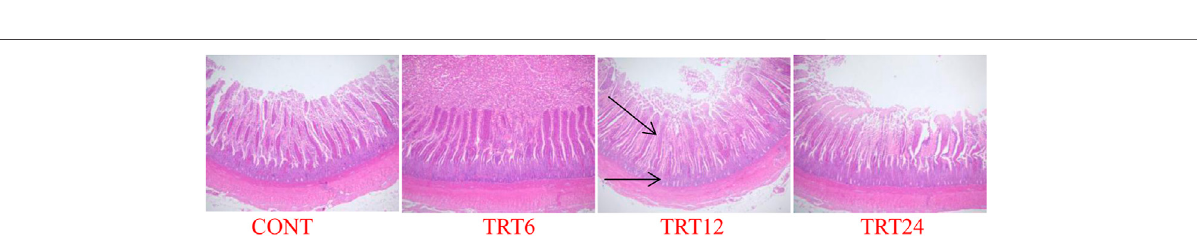
FIGURE 2 | Light micrograph of ileum morphology in meat geese (40 × multiple). Control geese (CONT) were fed a basal diet, whereas TRT6, TRT12, and TRT24 were fed a basal diet supplemented with 6, 12, or 24% alfalfa-mixed silage fermented material, respectively.